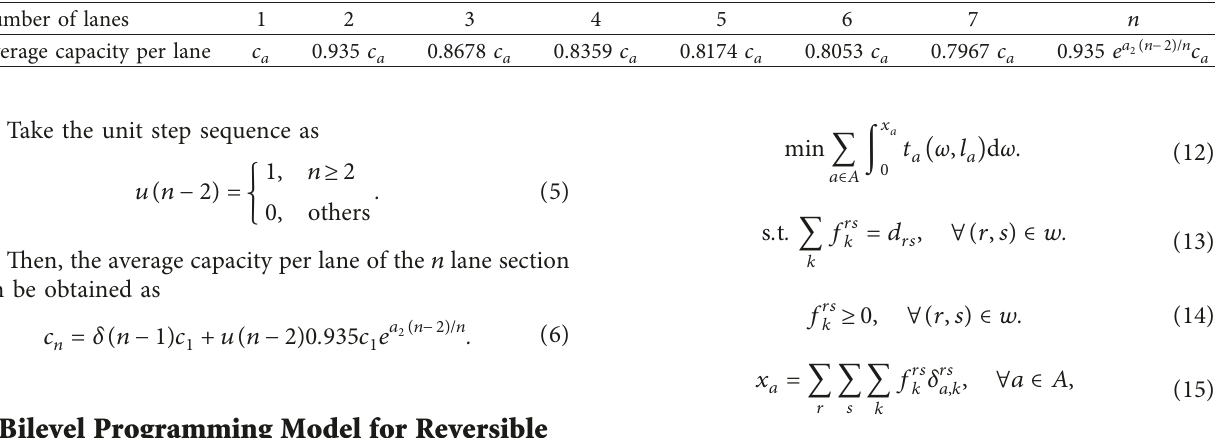
Table 1: Average capacity per